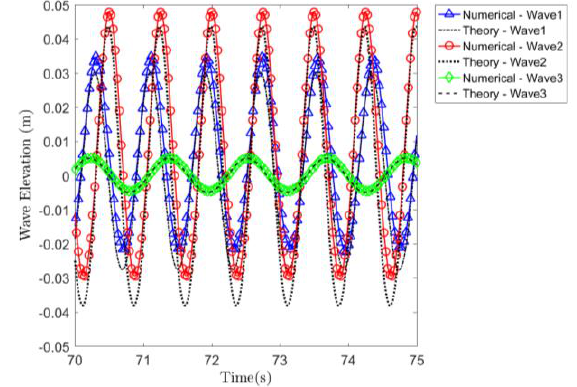
Figure 14. Surface elevation of Wave 1, 2 & 3 in intermediate water conditions at location 4m downstream of